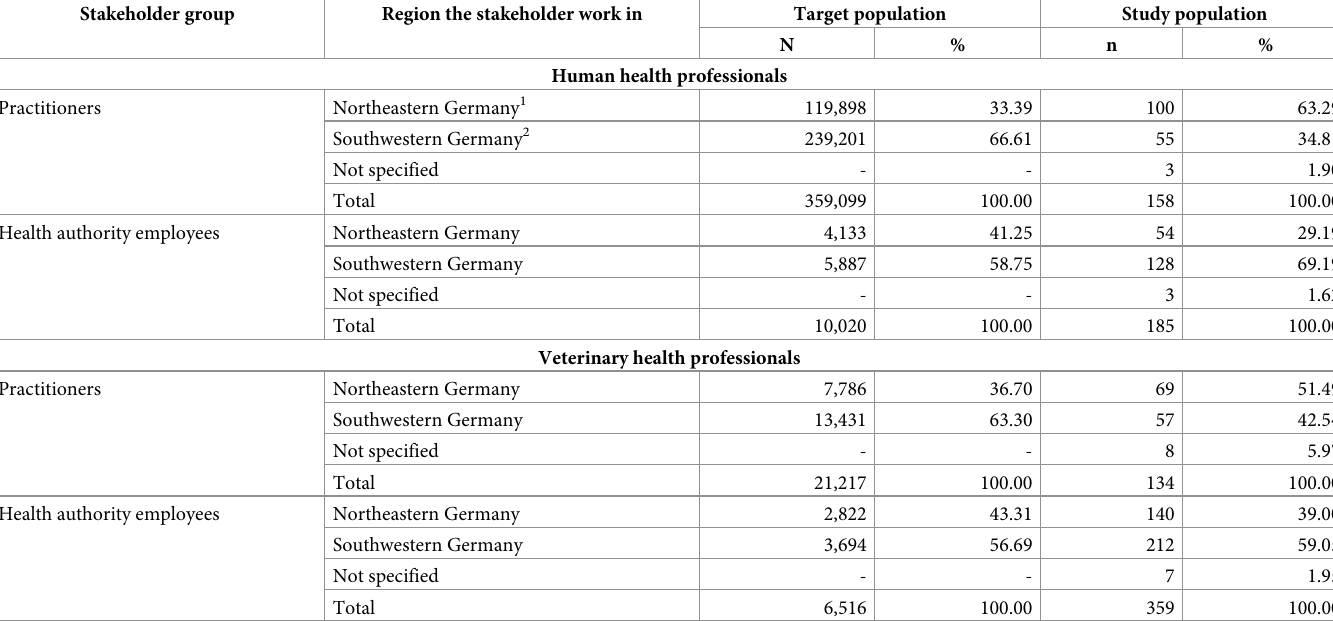
Table 2. Description of human and veterinary health practitioners of Germany based on the region they work in (online survey). Stakeholder